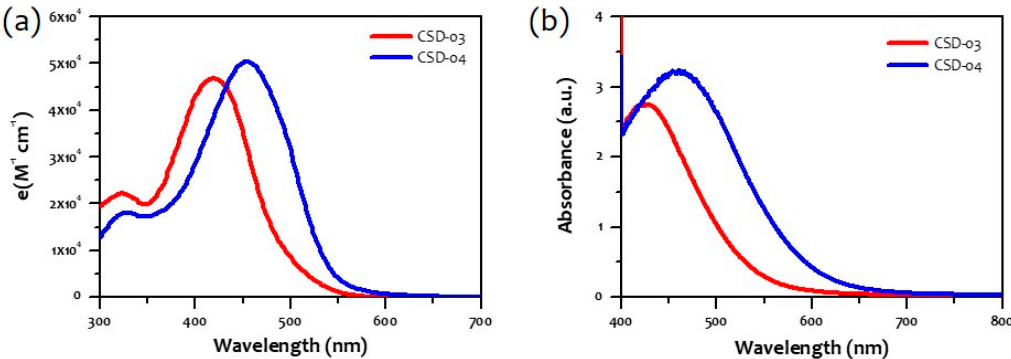
Figure 1. UV-visible absorption spectra of the two dyes ( a ) in DMF solution (1 × 10 − 5 mol L − 1 ) and ( b ) adsorbed onto transparent TiO 2 film.